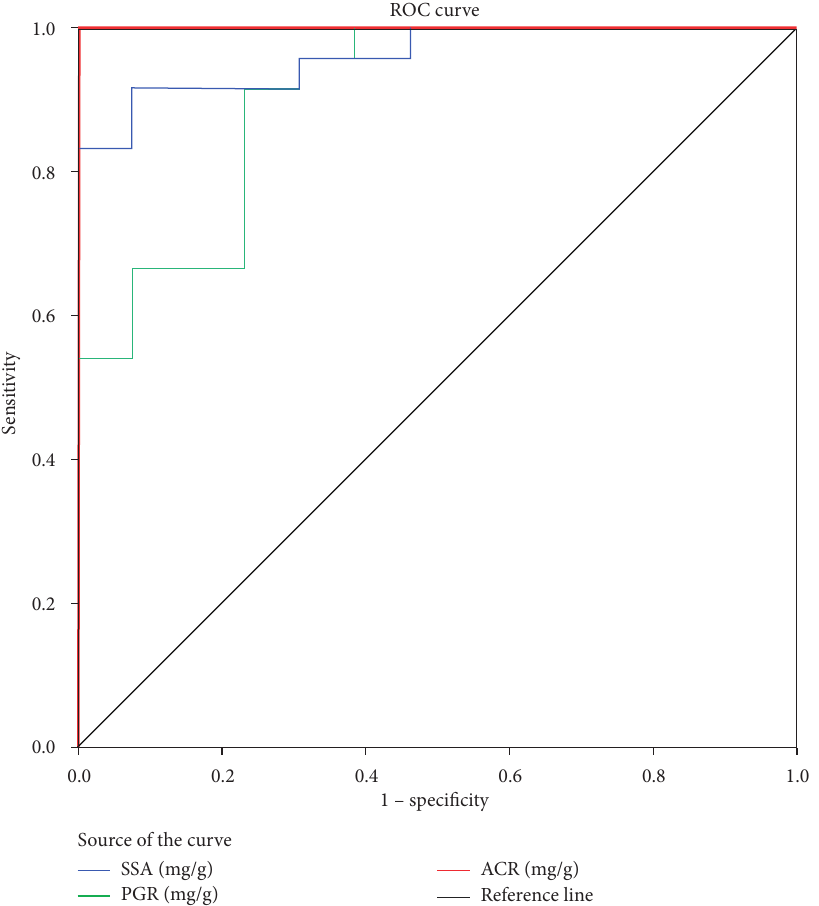
Figure 4: The summary plot of receiver operating characteristic curve in which 25% sulfosalicylic acid protein-to-creatinine ratios were compared with pyrogallol red protein-to-creatinine ratios in clinical applicability test. SSA: sulfosalicylic acid; PGR: pyrogallol red; ROC: receiver operating characteristic